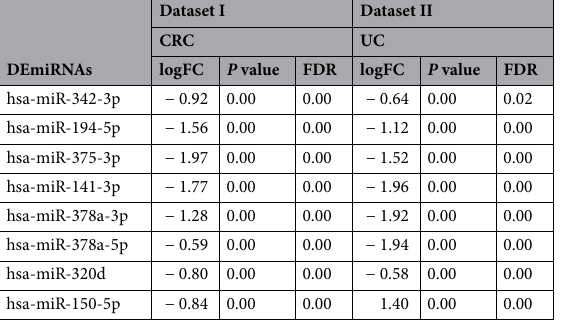
as differentially expressed molecules